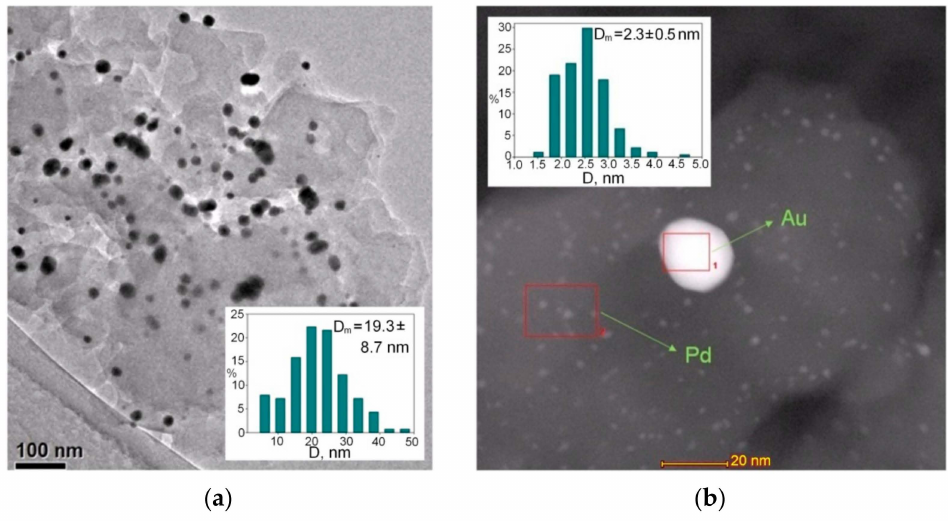
Figure 2. Bright-field ( a ) and dark-field ( b ) (scale 20 nm) STEM images of the reduced sample